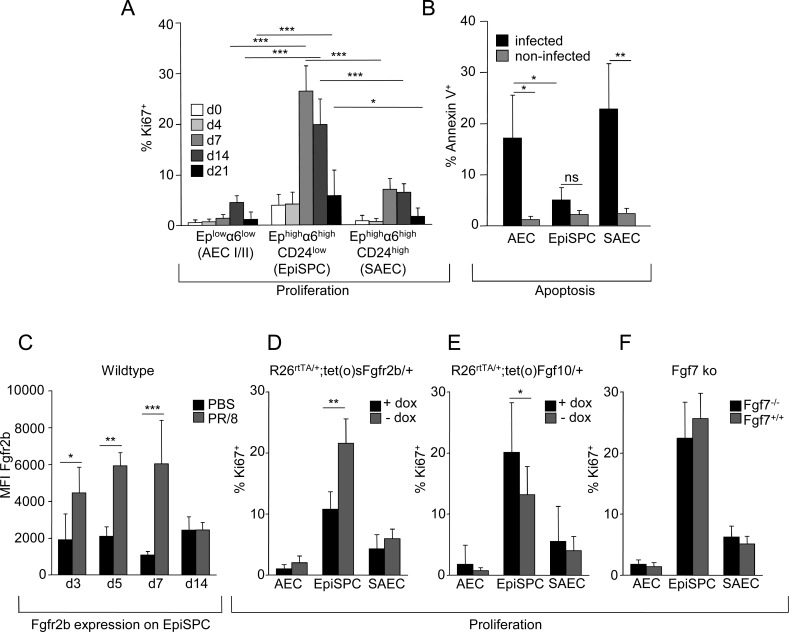
EpiSPC are resistant to apoptosis and show a high proliferative response after PR/8 infection which is mediated by Fgf10/Fgfr2b signaling.(A) Proliferation rates of the given epithelial cell subsets was analysed in PR/8 infected wt mice by FACS quantification of Ki67+ cells at the indicated time points pi. (B) Apoptosis of each EpCam+ subset was quantified by FACS (Annexin V+ proportions) at d7 post PR/8 infection and of non-infected wt mice. (C) Expression of Fgfr2b on EpiSPC at the given time points post PR/8 or mock infection was quantified by FACS and is given as MFI (median fluorescence intensity) of Fgfr2b ab minus MFI of matched isotype control. The proliferative response of the EpCam+ cell subsets was quantified by FACS at d7 pi in Rosa26
rtTA/+
;tet(O)sFgfr2b/+ (D) Rosa26
rtTA/+
;tet(O)Fgf10/+ mice (E) and Fgf7
-/- mice (F) compared to non-dox-induced or wt littermates. Bar graphs represent means ± SD of n = 4–6 independent experiments; * p<0.05; **p<0.01; +dox, doxycycline food; -dox, normal diet.